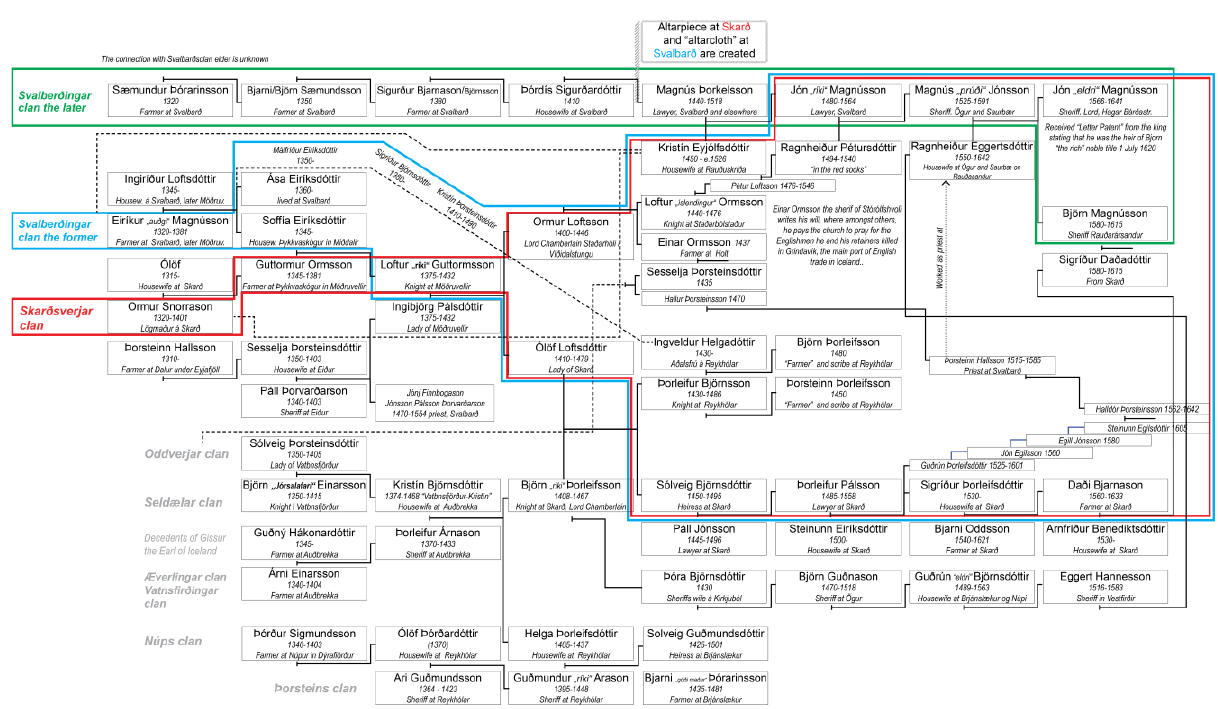
Figure 5. A table showing the connections of families from Skarð and Svalbarð (© Guðjón Þór Er- lendsson).